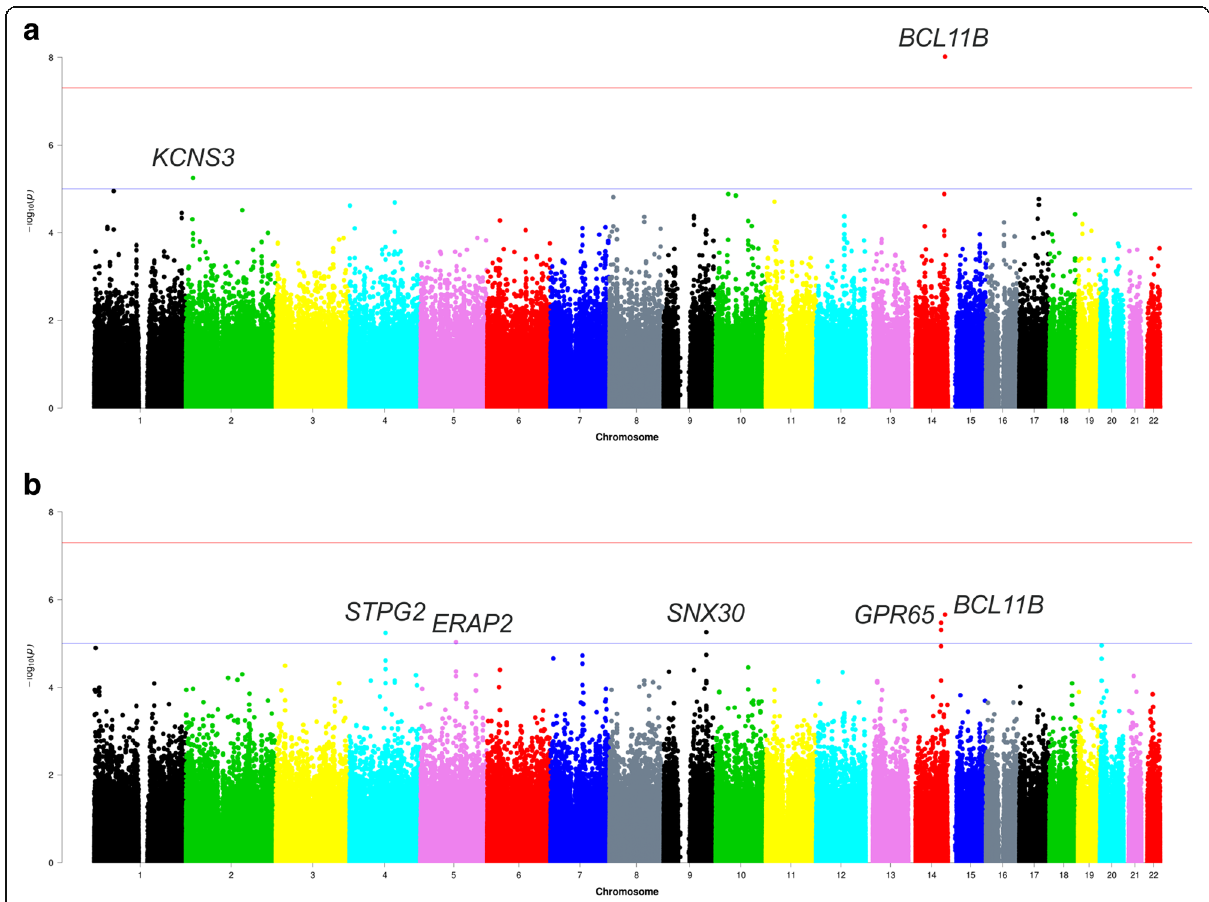
Fig. 1 Manhattan plots of the association P values from the discovery GWAS in GENRES. ( a ) SBP dipping ( b ) DBP dipping. The y-axis shows the -log 10 ( P values) of each genotyped SNP and the x-axis shows their chromosomal position. The horizontal lines correspond to genome-wide (5 × 10 − 8 ) and suggestive (1 × 10 − 5 ) P value thresholds. SNPs above the suggestive threshold are annotated. Abbreviations: GWAS; genome-wide association study; SBP, systolic blood pressure; DBP, diastolic blood pressure; SNP; single nucleotide